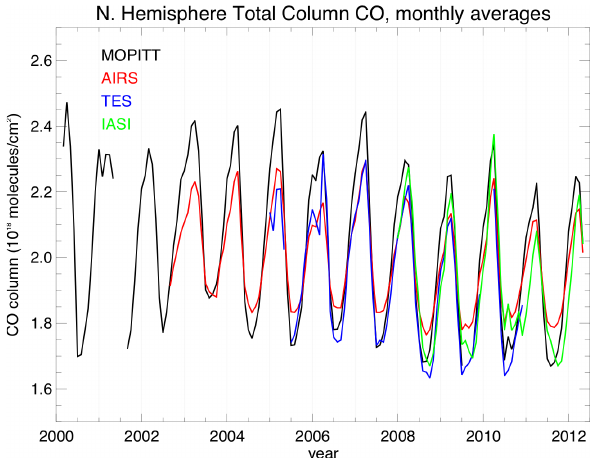
Figure 3. Time series of N. hemisphere (0-­‐60°N) monthly averages. Fig. 3. Time series of N. Hemisphere (0 ◦ –60 ◦ N) monthly averages.